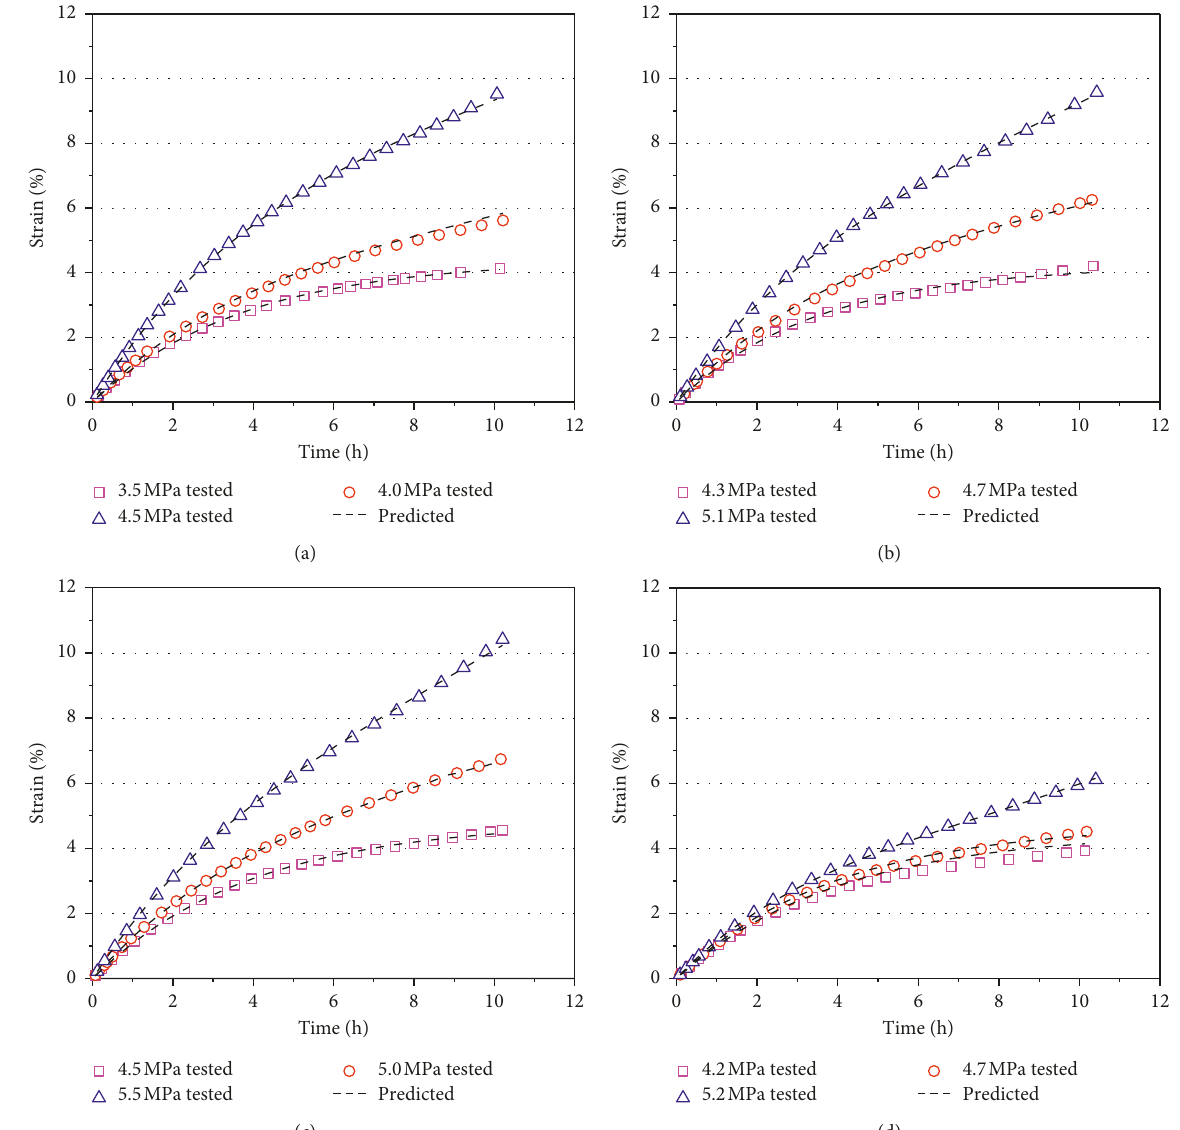
Figure 14: Comparisons between the experimental and calculation results ( σ